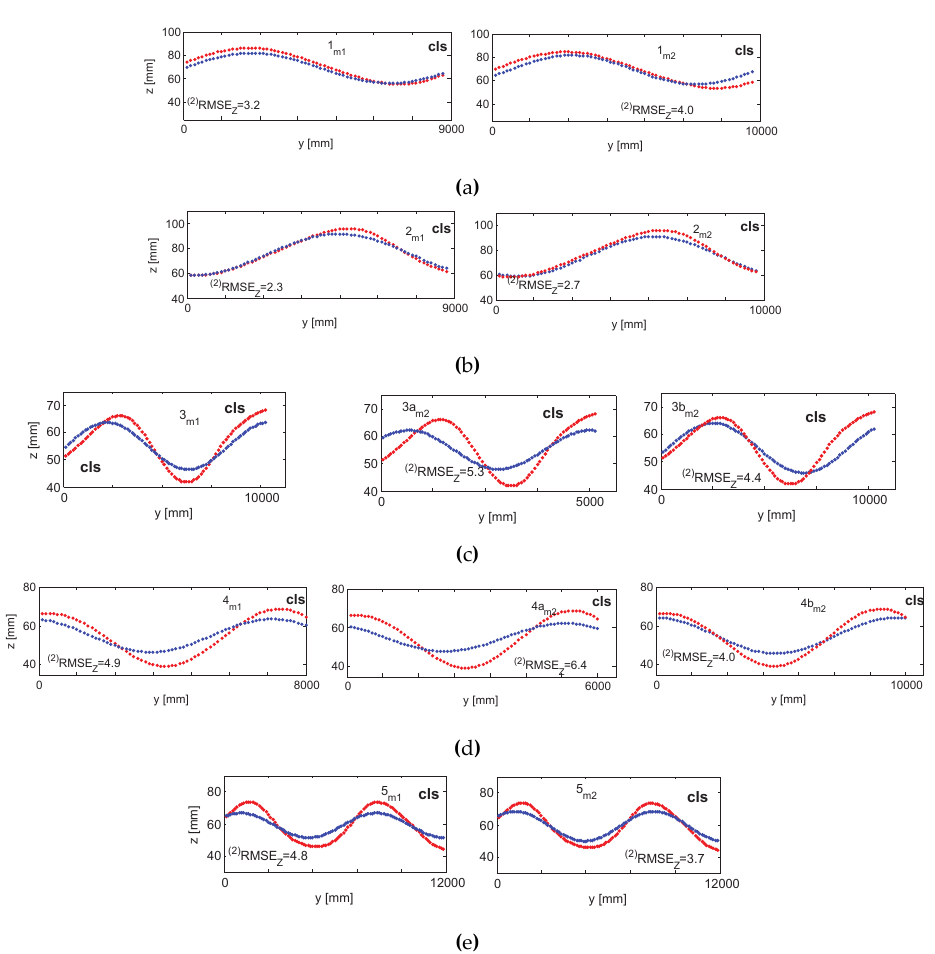
Figure 18. Accuracy 2 validation results for m 1 and m 2 in the 1–5 measurement series depicted in a – e , respectively. In red, the cls response; in blue the m 1, m 2 responses. All comparisons are carried out at the position of point cls